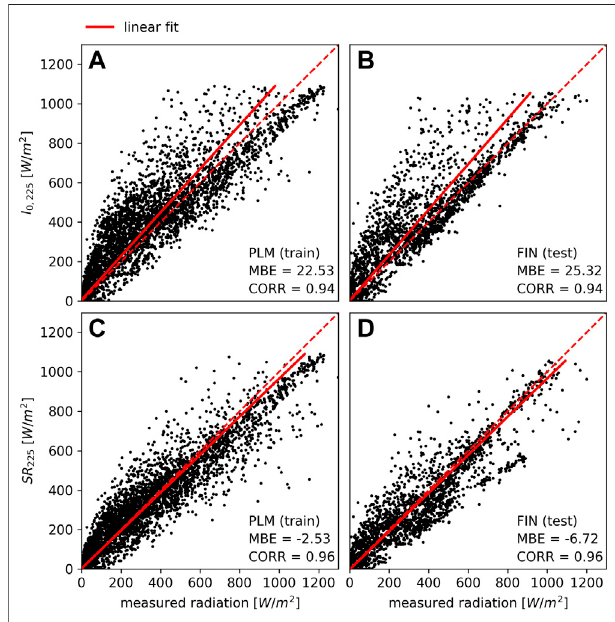
FIGURE4| Scatterplotinwhichthemodeledsolarradiation(I 0 ,225)and measured shortwave radiation, measured by the AWS located on Plaine Morte (A) and on Findel (B) are compared (C) compares the solar radiation adjusted with cloud cover information (SR 225 ) on Plaine Morte by minimizing the mean squared error of (A) (D) compares adjusted solar radiation with cloud cover information on Findel, using the correction factor obtained from Plaine Morte. The correlations (CORR) and mean bias errors (MBE) are reported on the graphs.